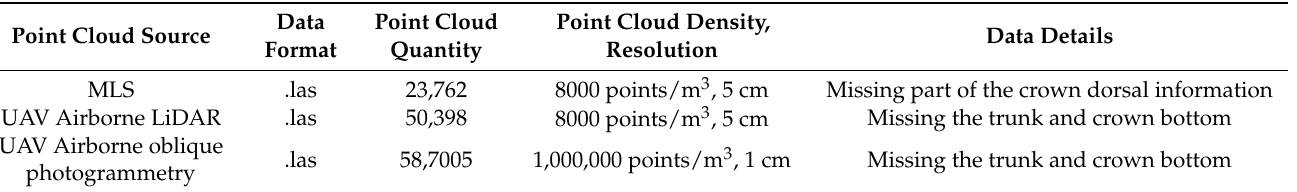
Table 2. Quality comparison of three types of point cloud data collected at the same site and in the same time